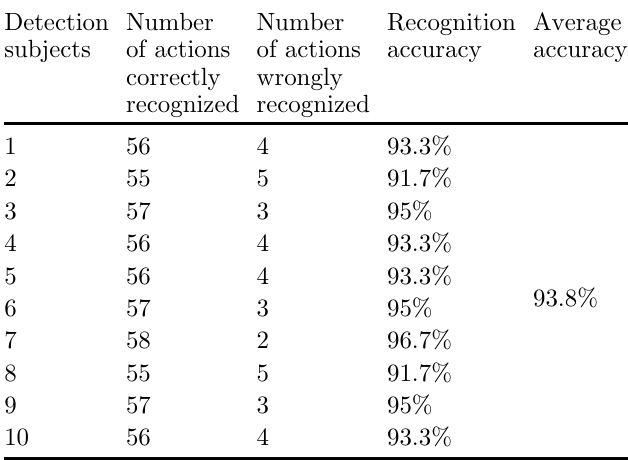
Fig. 5. Comparison of training time for different methods.